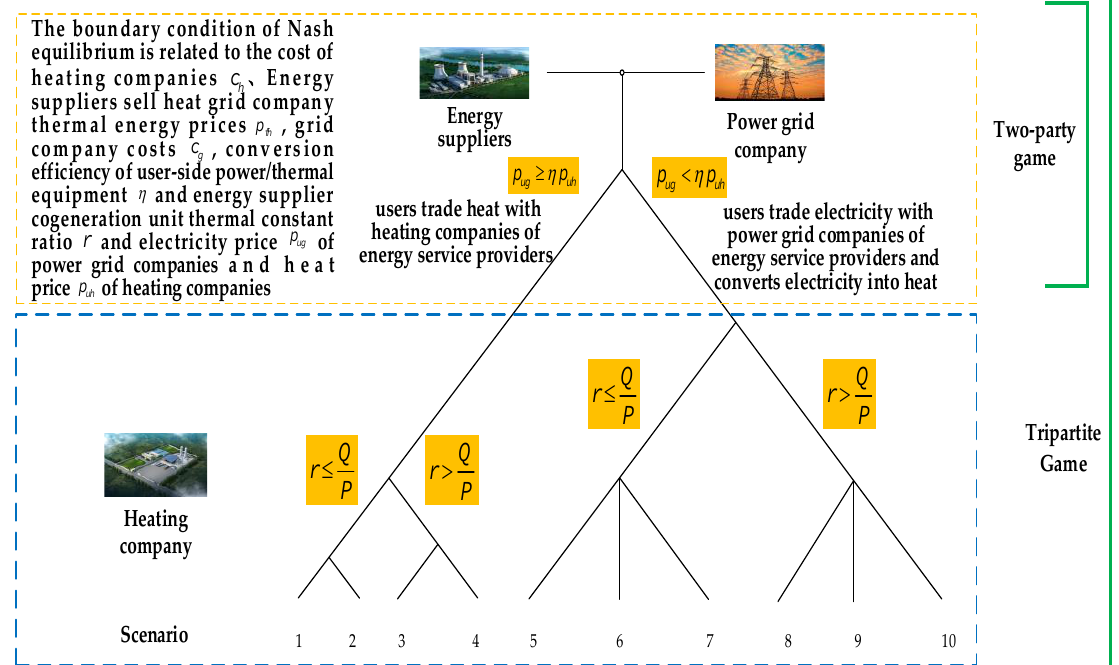
Figure 2. Game-tree diagram for the Nash equilibria solution of the tripartite game.